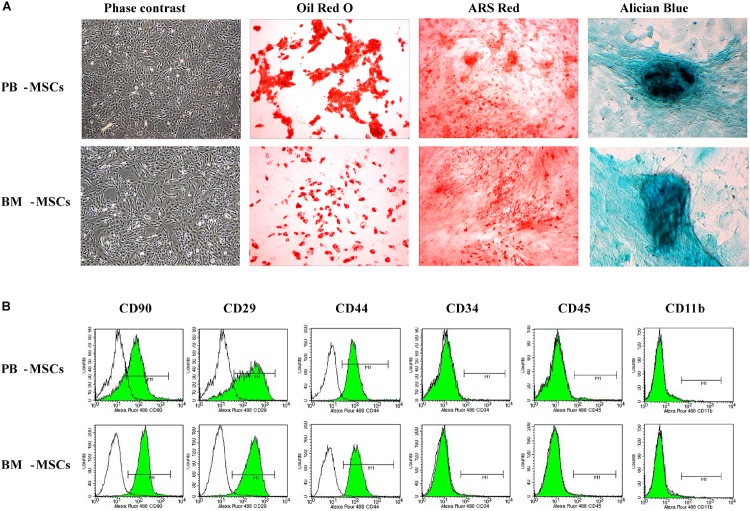
The morphologic and phenotypic characteristics and multiple-differentiation potential of BM-MSCs and PB-MSCs. (A) The typical image of third generation PB-MSCs and BM-MSCs with fibroblast-like shape. Osteogenesis of PB-MSCs and BM-MSCs was determined by Alizarin Red staining 21 days after osteogenic induction. Adipogenesis of PB-MSCs and BM-MSCs was detected via the formation of neutral lipid vacuoles stainable with Oil Red O staining 21 days after induction. Chondrogenesis of PB-MSCs and BM-MSCs was evaluated through Alician Blue staining 21 days after induction. (B) BM-MSCs and PB-MSCs were positive for CD44, CD29, and CD90, and negative for CD34, CD11b, and CD45.